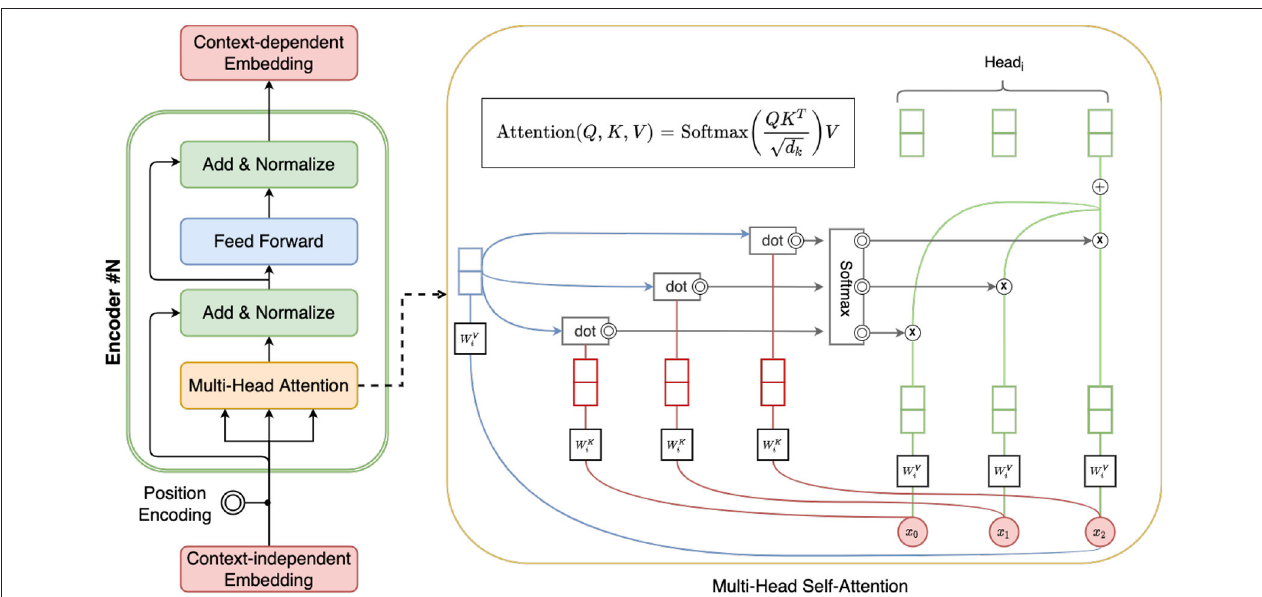
FIGURE 2 | Illustration of BERT and